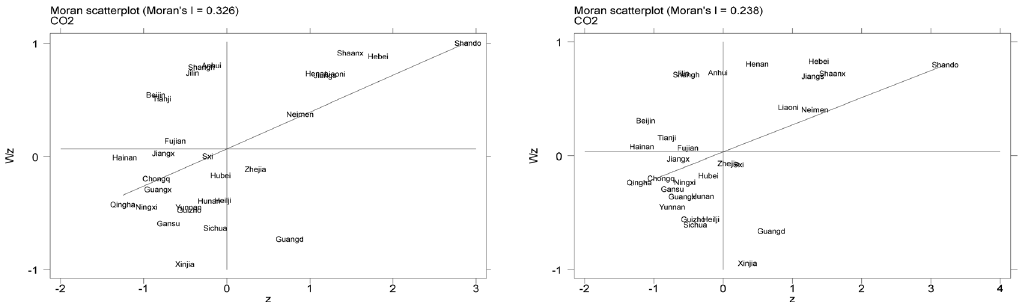
Figure 6. Moran’s I scatter diagram of CO2 in 2008 (left) and 2017